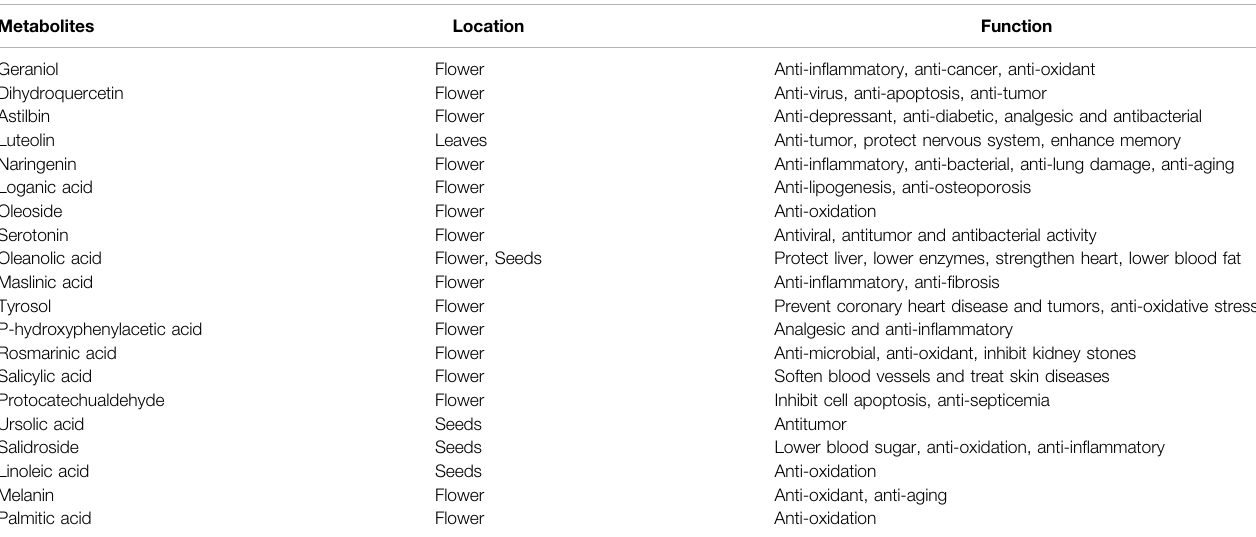
TABLE 2 | Medicinal ef fi cacy of major secondary metabolites in Osmanthus fragrans .